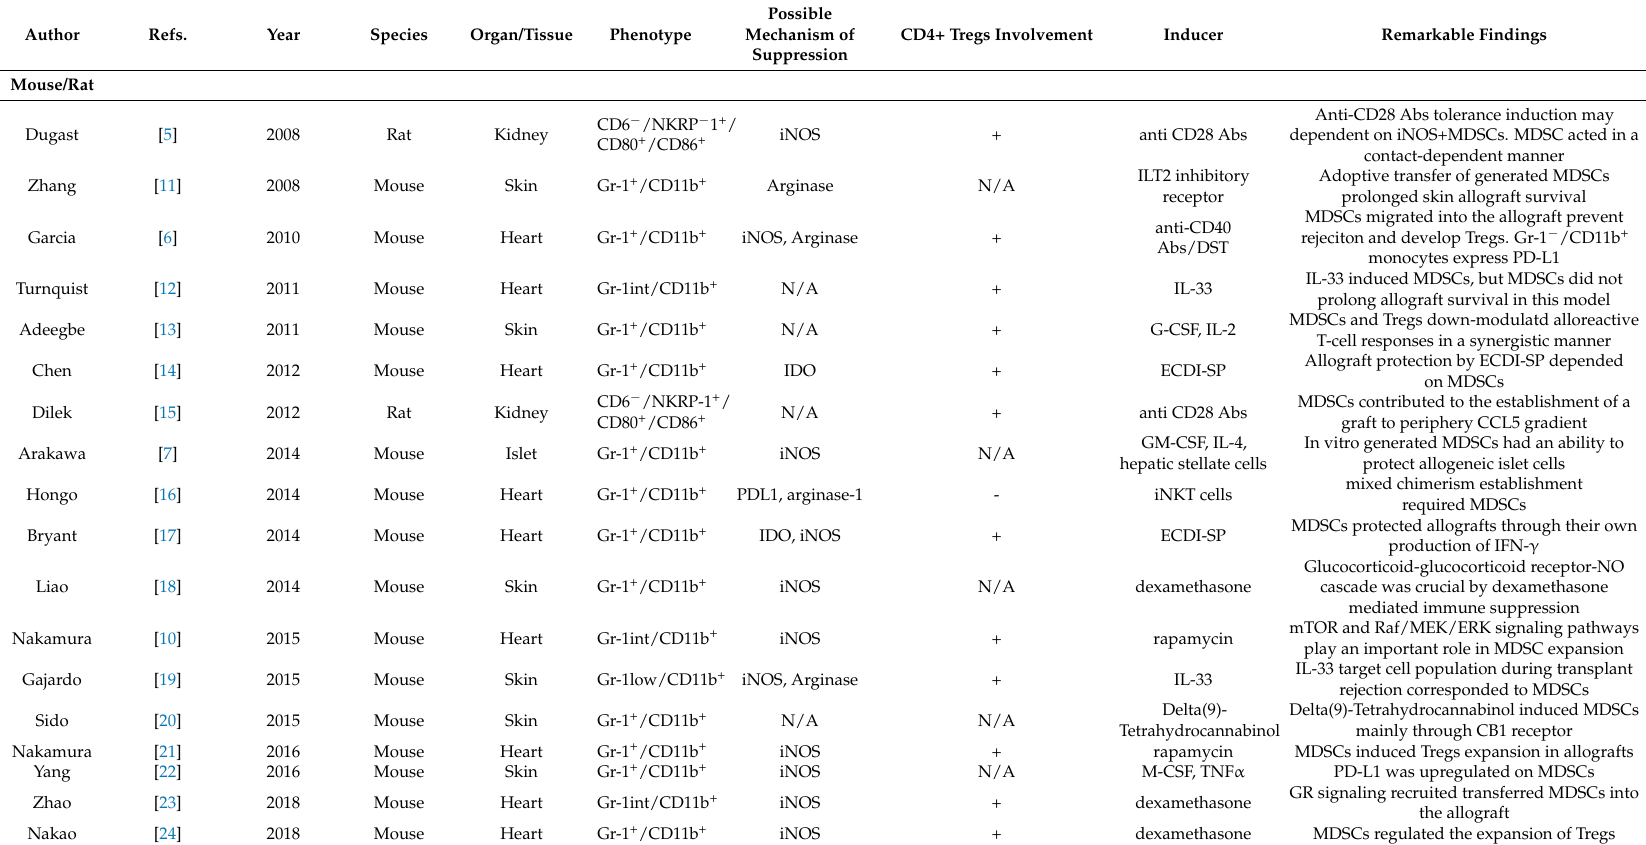
Table 1. MDSCs in